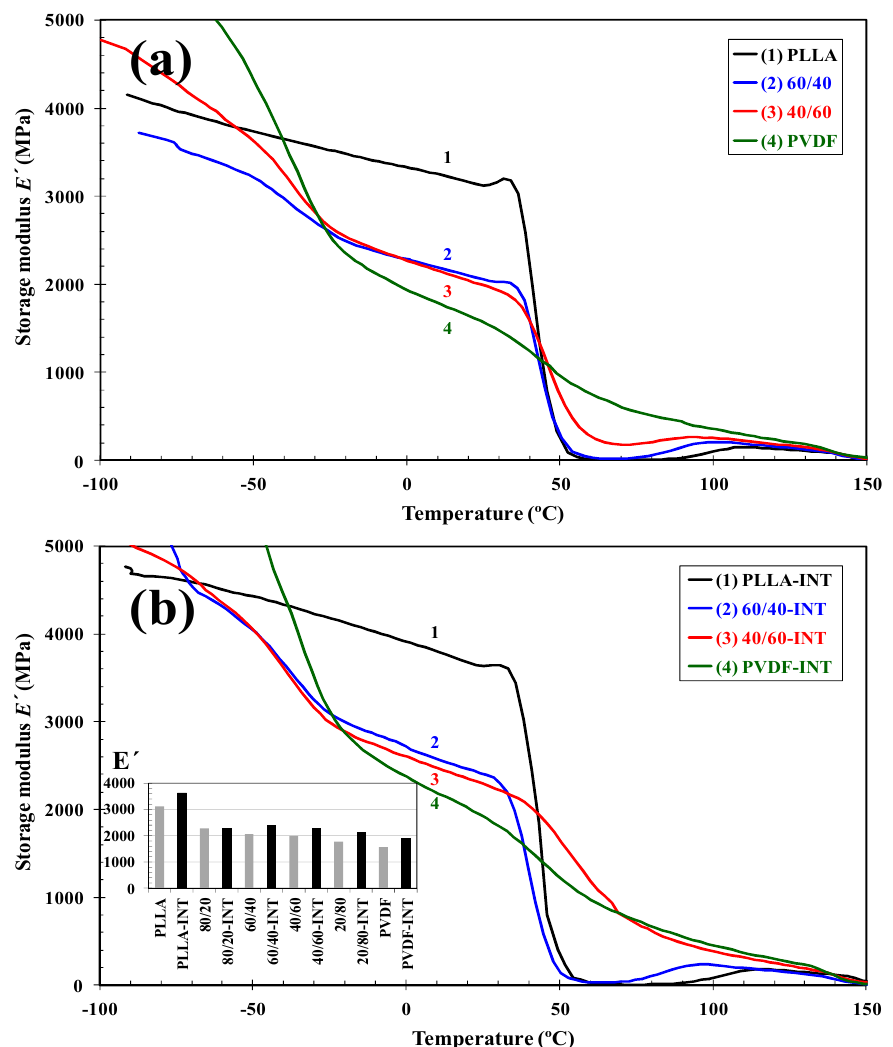
Figure 11. Evolution of the storage modulus ( E′ ) as a function of temperature for indicated ( a ) binary PLLA/PVDF and ( b ) ternary PLLA/PVDF/INT-WS 2 hybrid nanocomposites obtained in the tensile mode at 1 Hz; inset is the room temperature values of storage modulus ( E′ ) obtained for all binary and ternary hybrid nanocomposites. Table 3. DMA parameters of different PLLA/PVDF/INT-WS 2 blend nanocomposites based on PLLA, PVDF, and INT-WS 2 .